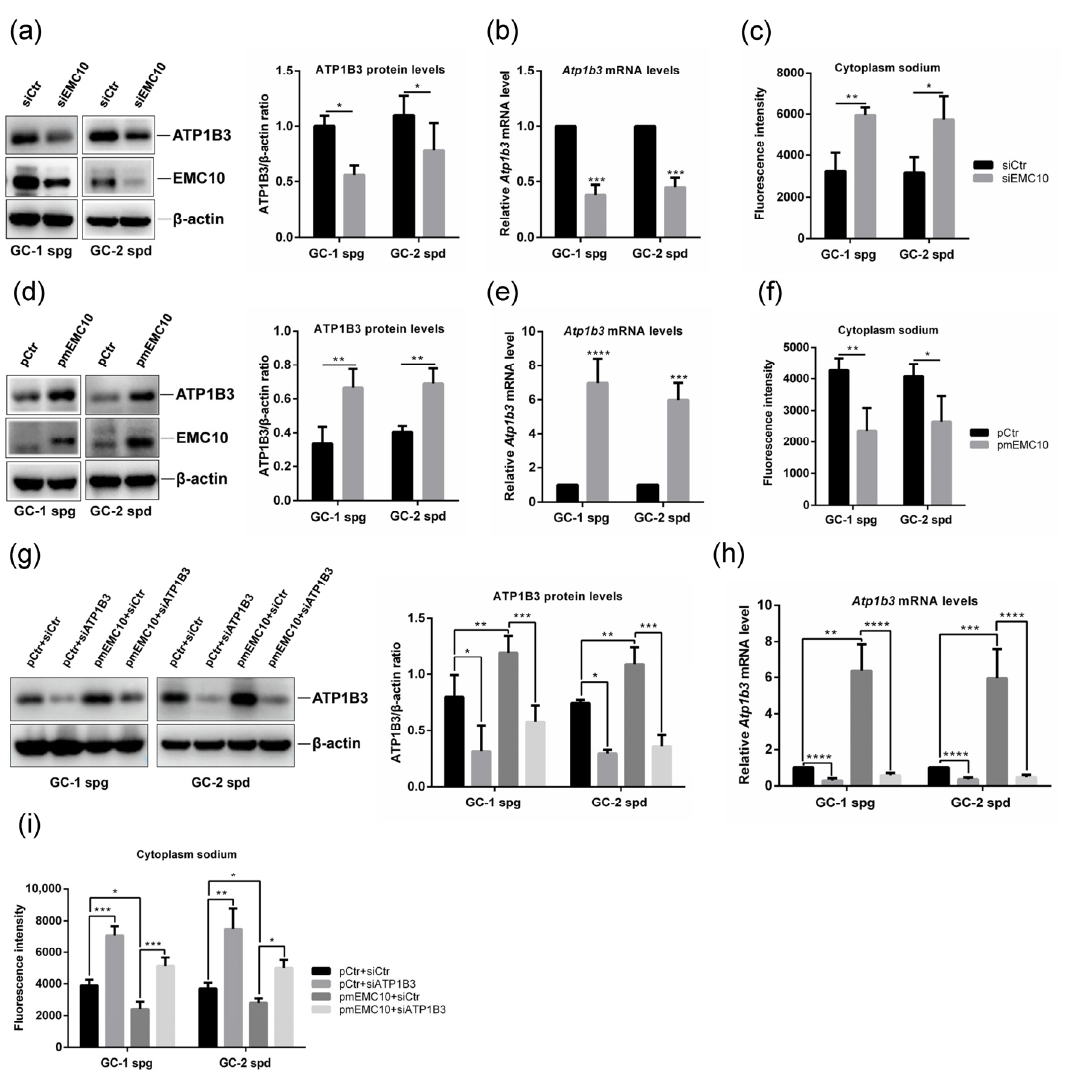
Figure 3. mEMC10 maintains the homeostasis of cytoplasm sodium via positively regulating ATP1B3 in germ cells. ( a ) The protein levels of EMC10 and ATP1B3 in GC-1 and GC-2 cells after the transfection of siRNA targeting mouse Emc10 gene or control siRNA for 48 h. ( b ) Atp1b3 mRNA levels in GC-1 and GC-2 cells transfected with the indicated siRNAs for 48 h. ( c ) Cytoplasm sodium was determined using CoroNa Green, a sodium-sensitive fluorescent dye, in Emc10 siRNA or control siRNA-transfected GC-1 and GC-2 cells. ( d ) mEMC10 and ATP1B3 protein expression, ( e ) Atp1b3 gene expression, and ( f ) cytoplasm sodium in GC-1 and GC-2 cells transfected with a plasmid-encoding mouse membrane-bound EMC10 or control plasmid for 48 h. The levels of ( g ) ATP1B3 protein, ( h ) Atp1b3 mRNA, and ( i ) cytoplasm sodium in GC-1 and GC-2 cells transfected with different plasmids and siRNAs as indicated for 48 h. siCtr, control siRNA; siEMC10, EMC10 siRNA; pCtr, control plasmid; pmEMC10, mEMC10 plasmid. * p < 0.05, ** p < 0.01, *** p < 0.001, **** p <